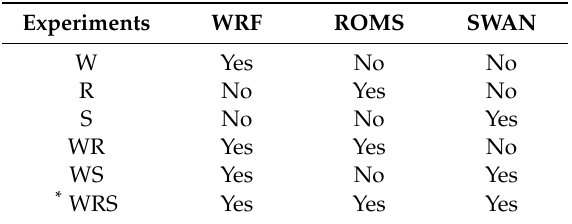
Table 2. List of sensitivity tests. WRF (W), ROMS (R), SWAN (S), WRF-ROMS (WR), WRF-SWAN (WS) and WRF-ROMS-SWAN